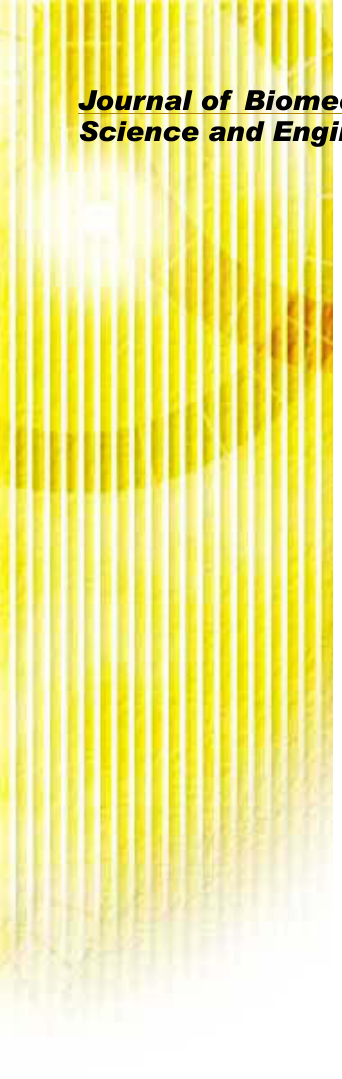
Figure 4. (A) Photograph of a microwell chip with outer dimensions of 26 x 76 mm, holding 672 microwells. (B) Smaller chips (10 x 10 mm) holding approximately 50 wells. (C) Micrograph of one well (650 x 650 µm) that has been coated with TiO . (D) Enlargement of a 2 smaller area of the coated microwell. Images (C-D) obtained using a light microscope. Scale bars: A-B: 1 cm, C: 100 µm, D: 10